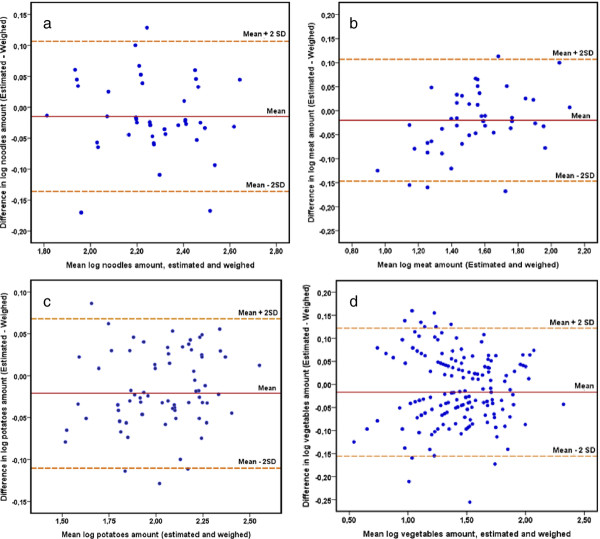
Bland Altman plots for estimated and weighed food amount. Differences between the log amounts of food portions estimated and weighed against their mean values, the solid line represents the average difference between the log estimated and the log weighed food amount; the dotted lines show the 95% log limits of agreement which, when calculating the antilog, represent the range of proportional agreement between both methods. a) Plot for noodles amount, b) Plot for potatoes, c) Plot for meat and d) Plot for vegetables. Plots show not systematic bias and that the range of proportional agreement is narrow enough to be confident using the photo method.